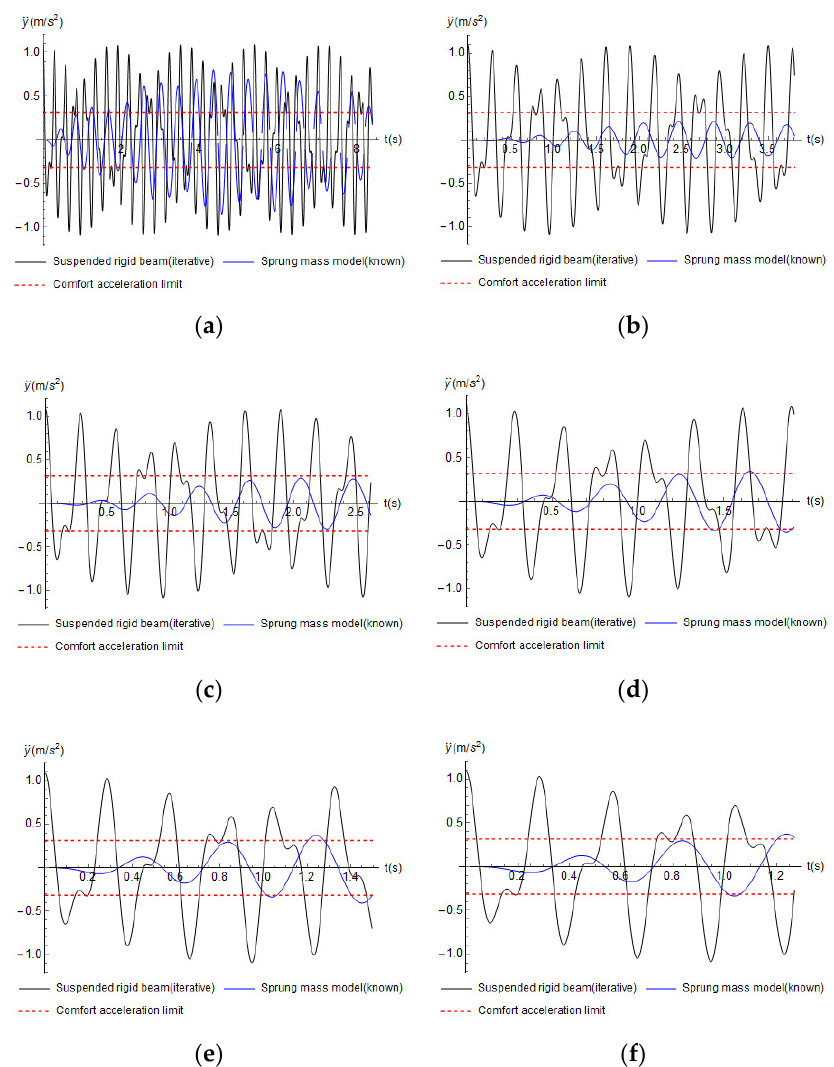
Figure 13. Vehicle responds in term of vertical accelerations for ( a ) v = 5.0 m/s, ( b ) v = 11.0 m/s, ( c ) v = 16.0 m/s, ( d ) 22.0 m/s, ( e ) 28.0 m/s, ( f ) v = 33.0 m/s.